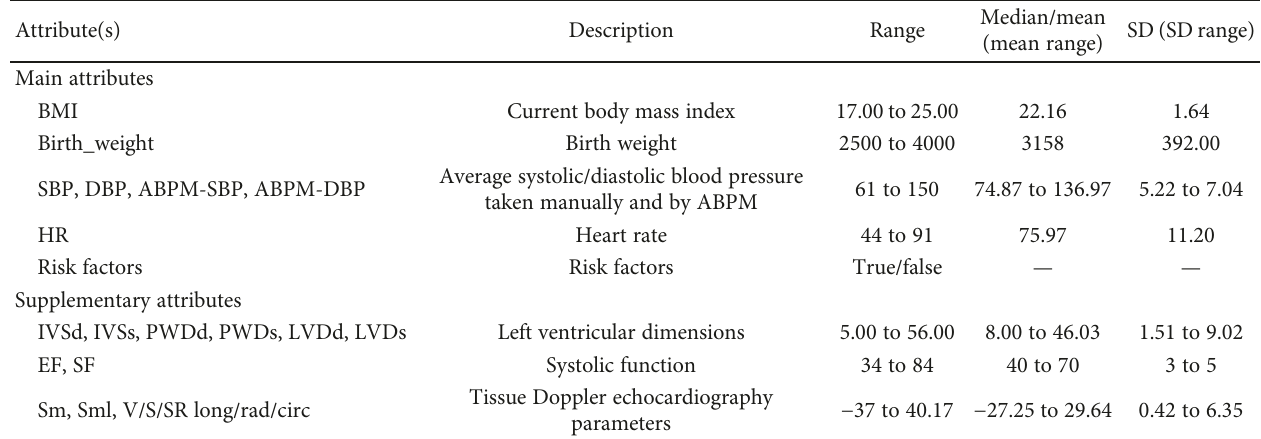
Table 2: Characteristics of attributes for the “ HEART ” dataset.